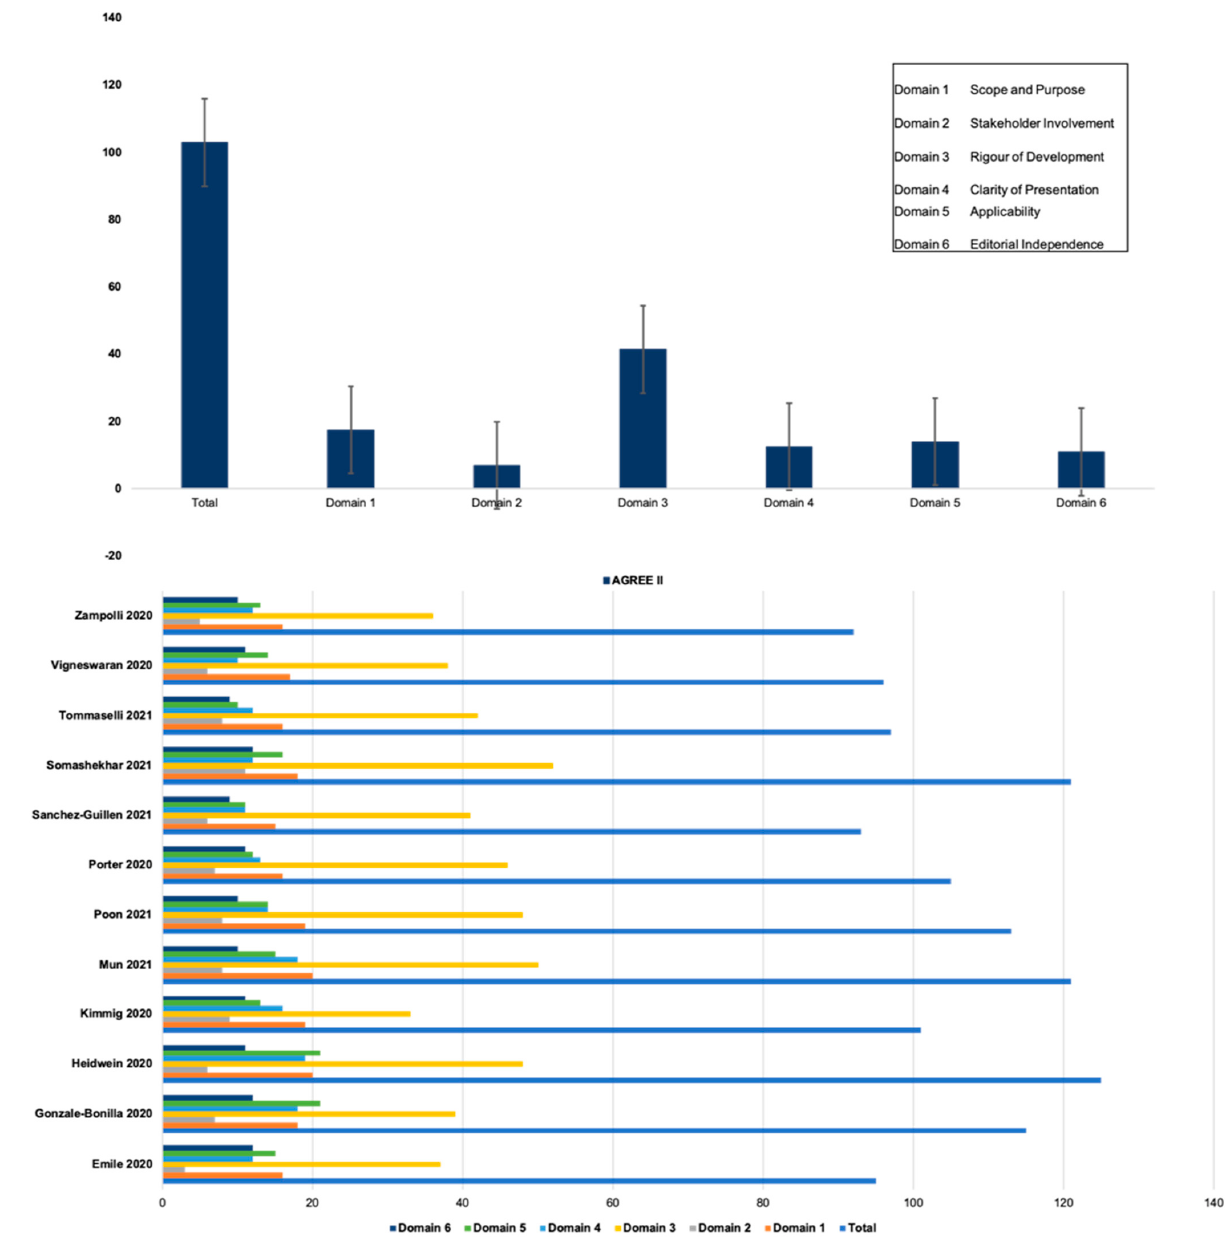
Figure 3. Study type and relevant surgical specialty for publications related to robotic-assisted sur- Figure 2. AGREE-II